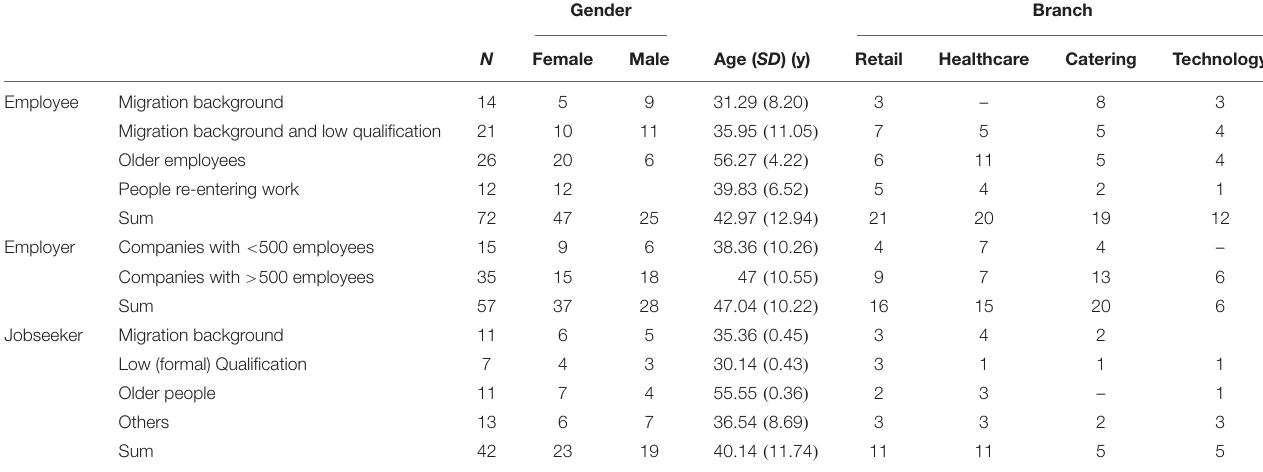
TABLE 2 | Sample characteristics.